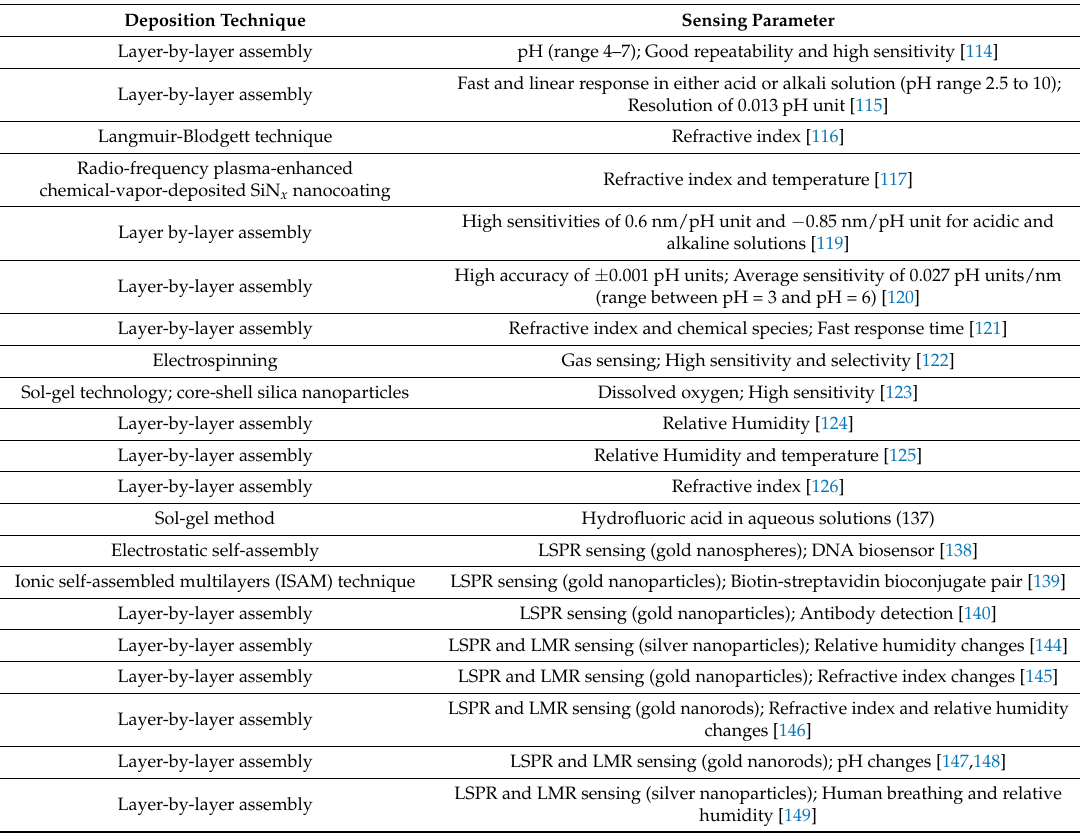
Table 5. Summary of the main application of the optical fiber sensors based on sensitive